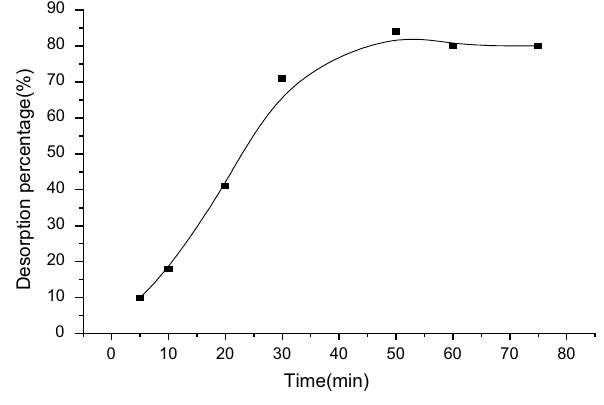
Fig. 7 Effect of time on carbaryl